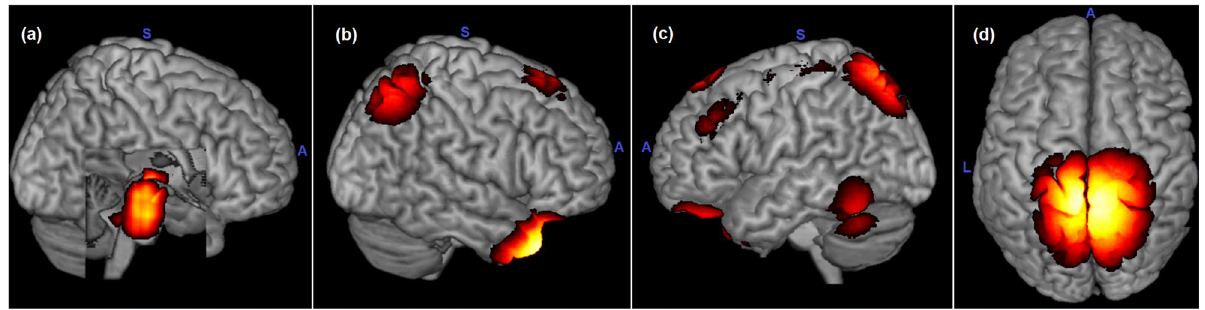
Figure 2. Top representative regions of age models. The images reflect models trained from ( a ) ABCD, ( b ) BHRCS, ( c ) ADHD-200, and ( d ) ABIDE-II. The attention maps were averaged from all cross-validation models. Note that ABCD attentions are subcortical regions. Acronyms: L = left, A = anterior, and S = superior.